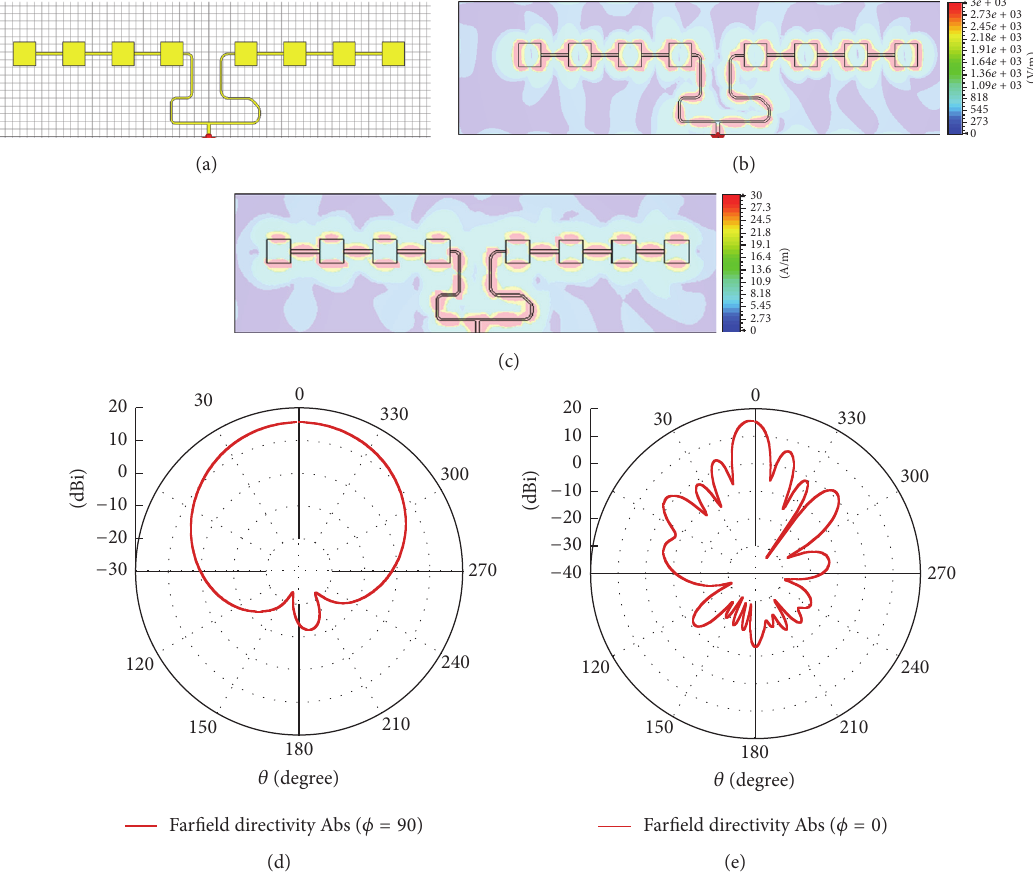
Figure 7: Receiving antenna geometry (a); 𝐸 𝑧 field distribution (b) and 𝐻 𝑧 field distribution (c) on the patch plane; sagittal (d) and azimuthal (e) radiation patterns.